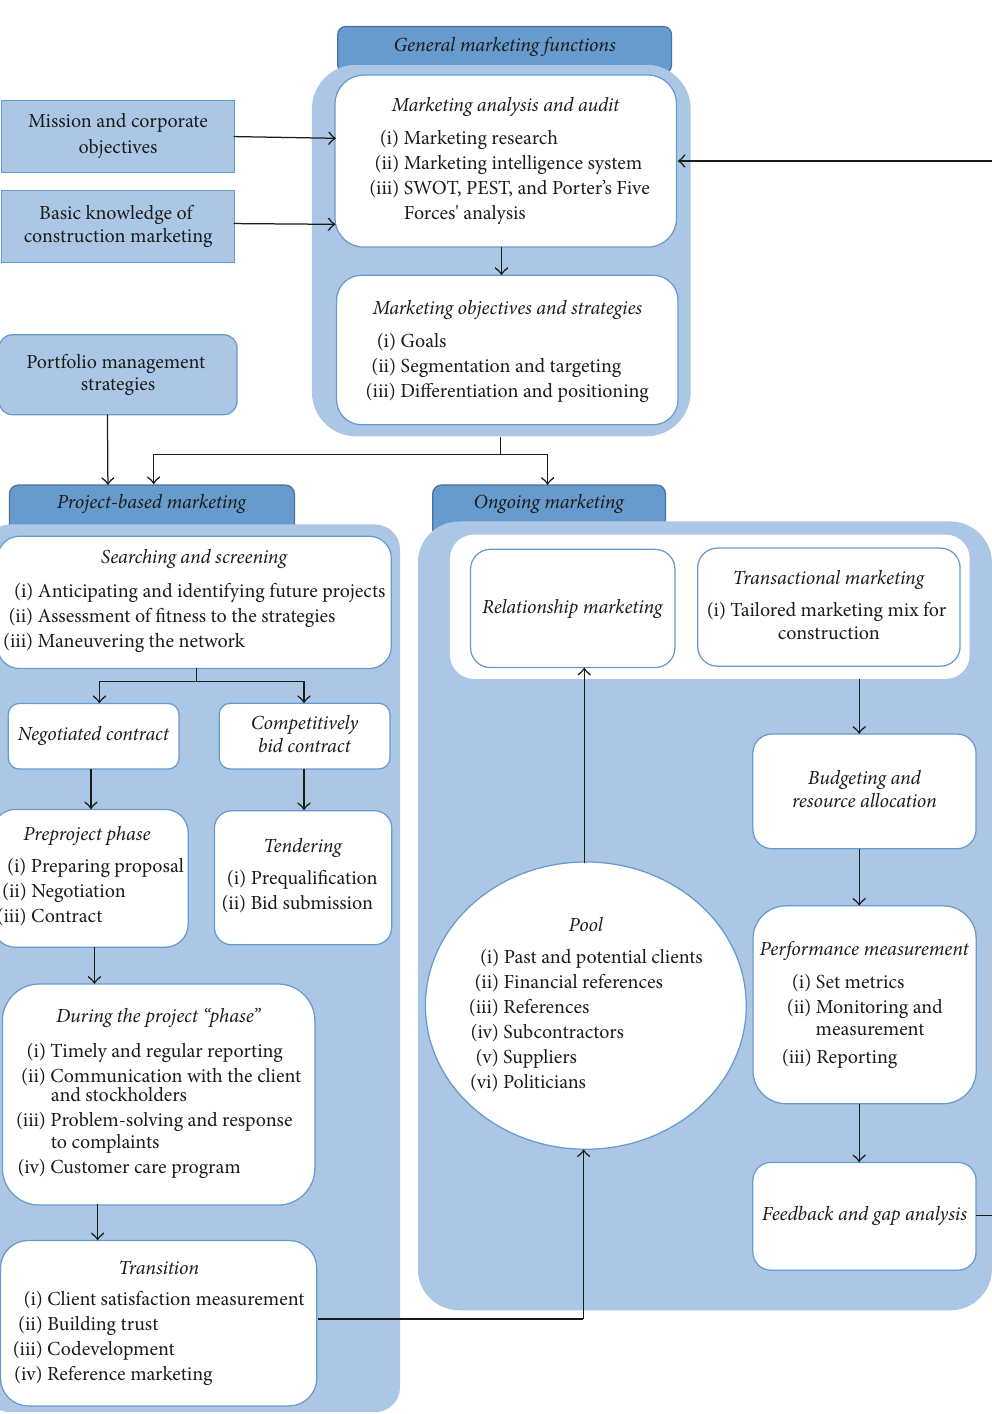
Figure 3: Reference framework of construction